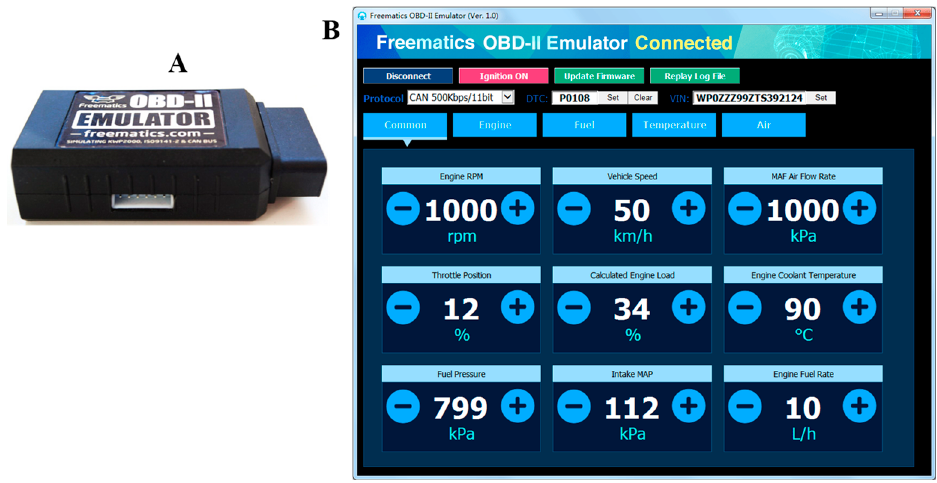
Figure 9. Freematics OBD-II Emulator MK2 (A) and Graphical User Interface (GUI) (B).